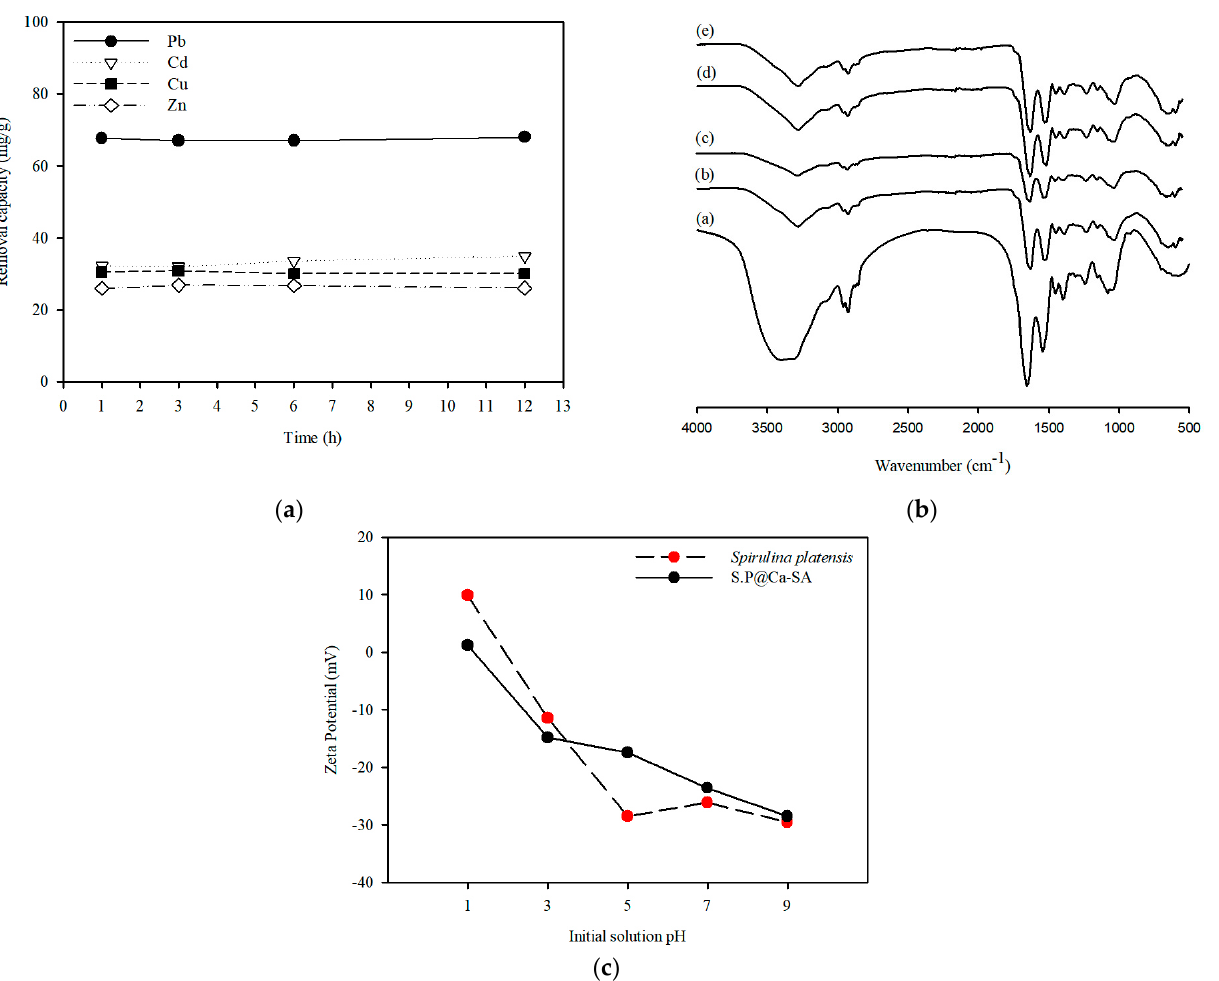
Figure 3. ( a ) Effect of contact time on adsorption capacity of Pb( Ⅱ ), Cu( Ⅱ ), Zn( Ⅱ ), and Cd( Ⅱ ) ions. ( b ) Fourier-transform infrared spectroscopy of Spirulina platensis before (a) and after adsorption (b– e) (Note: Spirulina platensis after adsorption using Pb(b), Cd(c), Cu(d), and Zn(e), initial concentra- tion of 100 mg/L, respectively). ( c ) Zeta potential as a function of pH for Spirulina platensis and